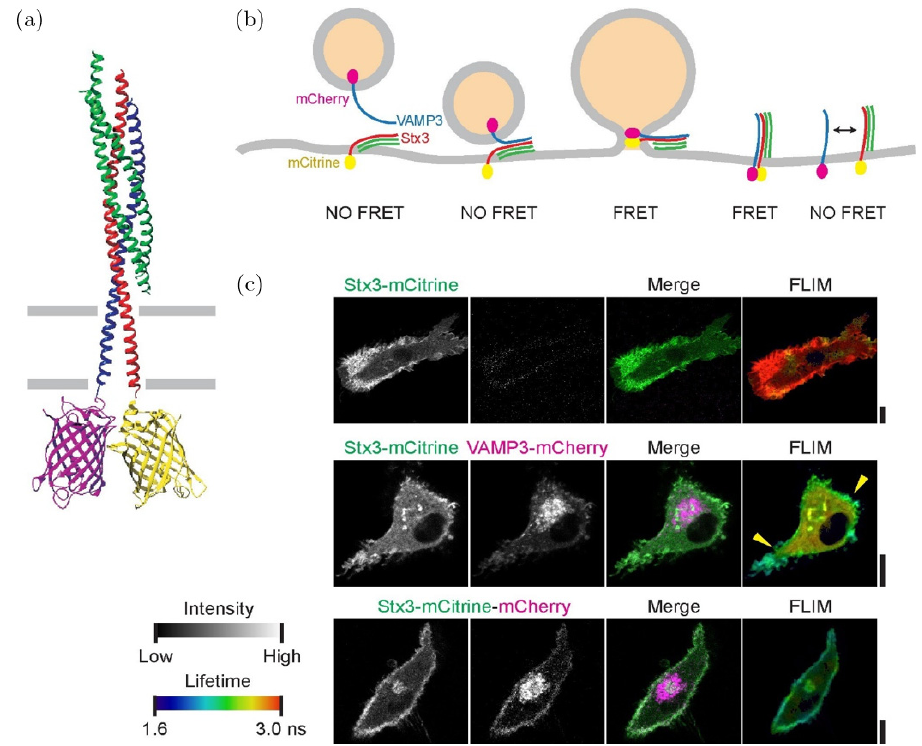
Fig. 5. SNARE complex formation by FRET – FLIM. (a) Model of the neuronal SNAREs; (b) Scheme of membrane fusion resulting in FRET; (c) Representative confocal microscopy (left) and FLIM (right) images of dendritic cells expressing Stx3-mCitrine (green in merge; upper panels), Stx3-mCitrine with VAMP3-mCherry (magenta; middle panels), or Stx3 conjugated to both mCitrine and mCherry (Stx3-mCitrine-mCherry; lower panels).